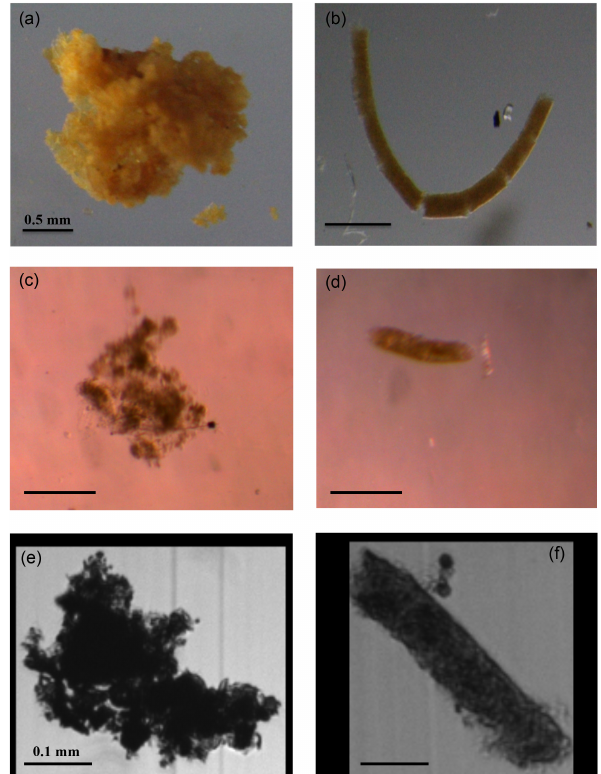
Figure 2. Particle images from the three different regions: the Southern Ocean (a, b) , the PAP site (c, d) , and the ETNP (e, f) . Panels (a, c, e) are phytodetrital aggregates and panels (b, d, f) are faecal pellets. Panel (b) is a chain of krill pellets from the SO and panels (d, f) are copepod pellets. Scale bars are 0.5mm for the SO and PAP images (a–d) and 0.1mm for the ETNP (e, f) . A stereomi- croscope was used in the SO, a compound microscope at PAP, and a FlowCAM in the ETNP, giving rise to the different background colours and